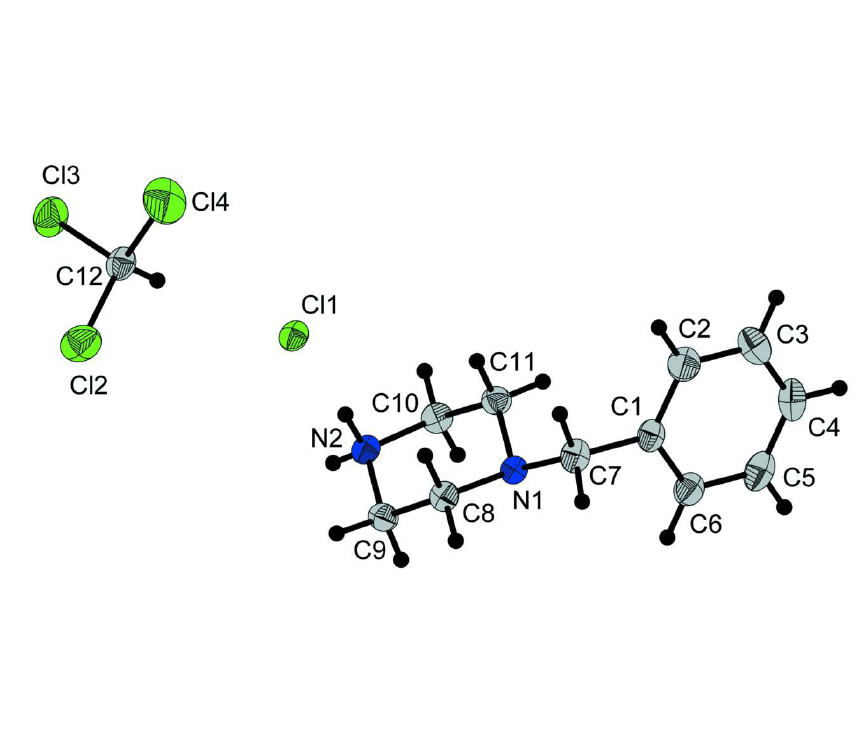
Figure 1 View of the title compound showing the atom-numbering (50% probability thermal